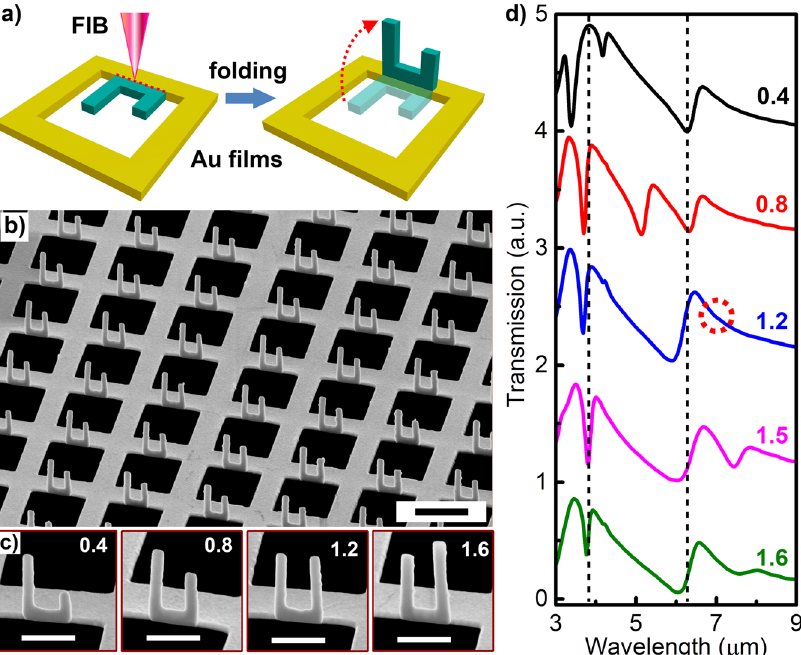
Figure 5. Experimental demonstrations. ( a ) Schematic of the fabrication process with a home-developed ion-beam irradiation-induced folding technique. ( b ) Side-view SEM images of fabricated 3D structures with H Arm1 = 1.2 µ m and H Arm2 = 0.8 µ m. Scale bar: 2 µ m. ( c ) Side-view SEM images of fabricated aSRRs with different H Arm2 as noted while H Arm1 is fixed at 1.2 µ m. Scale bars: 1 µ m. ( d ) Measured transmission spectra of the fabricated structure with H Arm1 = 1.2 µ m and different H Arm2 as noted. Each spectrum from bottom to top is vertically shifted by one unit compared to that below it. The vertical dashed curves denote the initial positions of F1 and F3, respectively, where F2 is tuned across. The dashed circles indicates the singularity in F1-F2 anticrossing when H Arm1 = H Arm2 = 1.2 μ m. Other structural parameters are the same as in Fig.